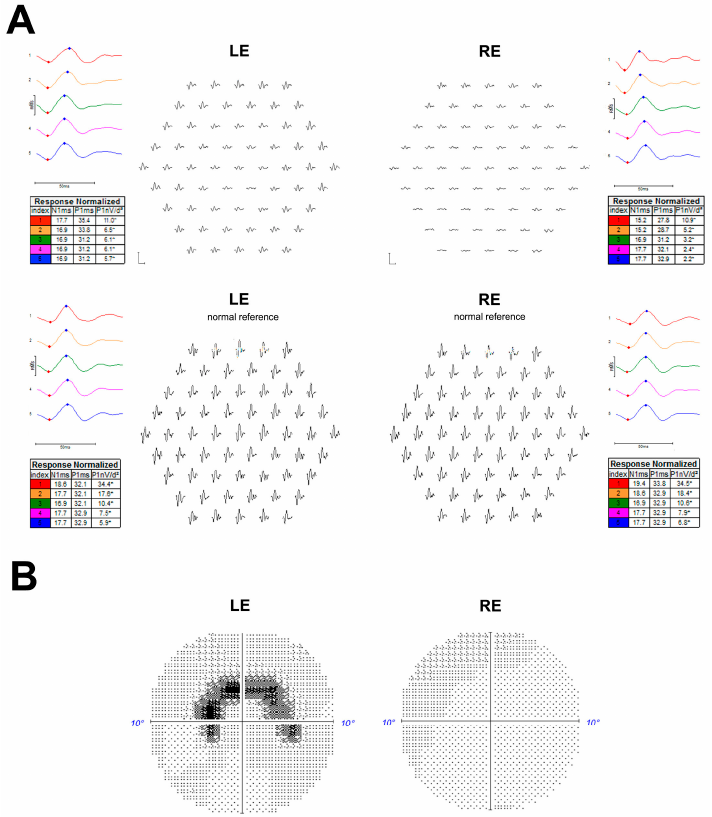
Figure 1. Multifocal Electroretinogram (ERG) (graphs and ring ratios) recorded with Dawson, Trick, and Litzkow (DTL) electrodes on a Diagnosys ® system, (Dyagnosis LLC, Cambridge, United Kingdom (2020) (traces from the patient are presented in the upper part with responses from a normal subject in the lower part on retinal view display) with decreased pericentral responses in the second and third ring of the left eye and decreased responses in the fourth and fifth ring in the right eye ( A ). Left and right eye 10-2 Swedish interactive thresholding algorithm (SITA) fast Humphrey visual field, respectively, showing paracentral horse-shoe-shaped scotoma and peripheral supero-nasal campimetric alteration ( B ). LE = Left eye; RE = Right eye.